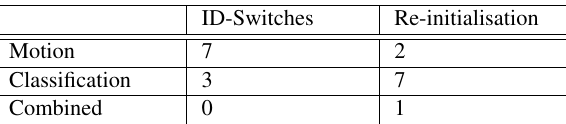
Figure 3: Classification results after sequential training. The classification confidence is plotted in the diagrams for the blue (left), red (middle) and yellow (right) framed tracking objects in the according colours below the image frames. The shown frames are captured one instance of time after initialisation (left) and 40 frames later (right).